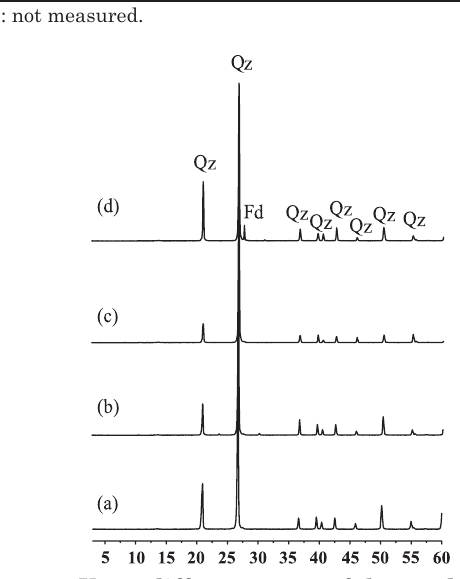
figure 1. X-ray diffractometry of the sand fraction of soils developed from sediments of the river taquari watershed in the Pantanal of Mato grosso do sul. a: bay area P1 (Bhs2 60–78 cm); r. Bras. Ci. solo, 36:697-707, 2012